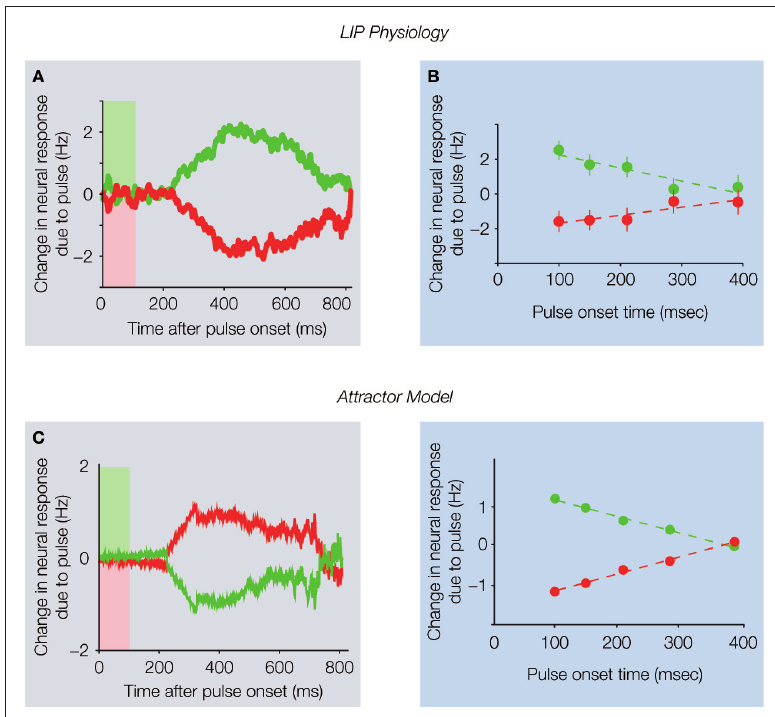
Figure 3 | Brief motion pulses exert persistent effects on neural activity. (A) A brief 100 ms motion pulse during motion discrimination of random dot stimulus exerts a long-lasting change in LIP neuronal firing rates. Green (red) trace: positive (negative) pulse in the same (opposite) direction as the random dot motion coherence. Data grouped over all pulse onset times and motion coherences. (B) Violation of time-shift invariance (TSI): instantaneous change in LIP activity due to pulse is not a constant, but decreases with later motion pulse onset time relative to the random dot motion stimulus onset. Green and red: same as (A) . (C) Attractor model reproduces experimental data (A,B) . (A,B) adapted from Huk and Shadlen (2005), with permission; (C) from Wong et al.